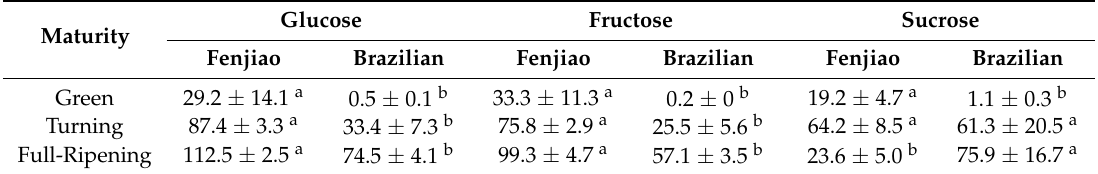
Table 1. Changes in soluble saccharide content in banana fruit at various stages of ripening (mg · g − 1 ). Glucose Fructose Sucrose Maturity Fenjiao Brazilian Fenjiao Brazilian